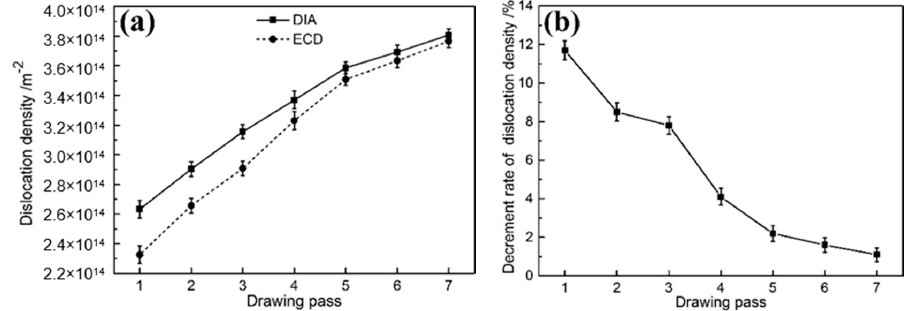
Figure 3. Variations ( a ) dislocation density of ECD and DIA bars and ( b ) decrement rate of dislocation density of ECD bar compared with DIA bar with drawing pass.